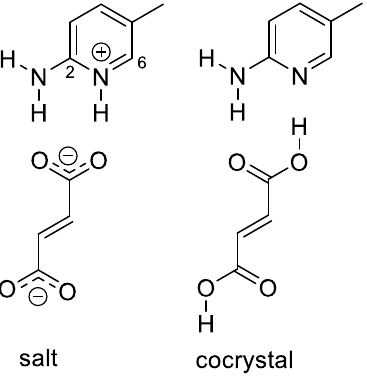
Figure 2. The salt and cocrystal forms of system 4 (DUTNUC).